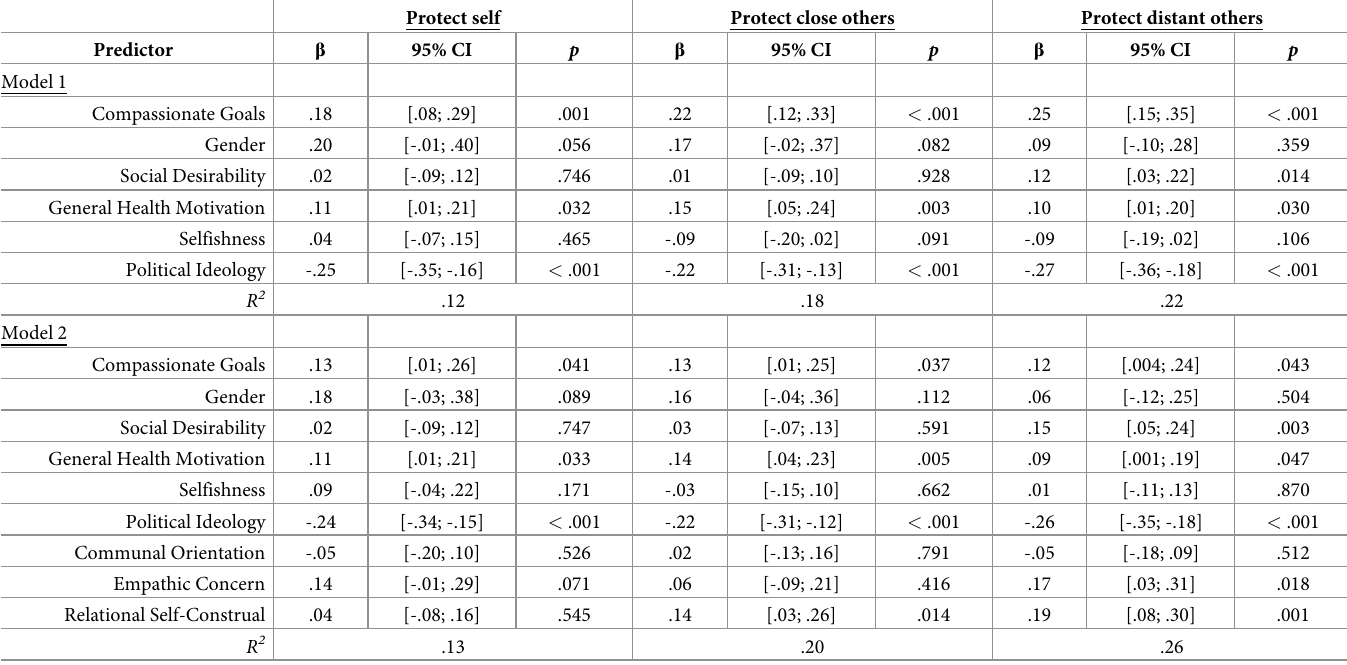
Table 11. Coefficients from multiple regression models predicting reasons for COVID-19 health behaviors in Study 3. Protect self Protect close others Protect distant others Predictor β Model